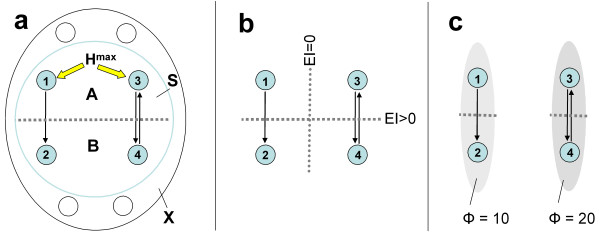
Effective information, minimum information bipartition, and complexes. a. Effective information. Shown is a single subset S of 4 elements ({1,2,3,4}, blue circle), forming part of a larger system X (black ellipse). This subset is bisected into A and B by a bipartition ({1,3}/{2,4}, indicated by the dotted grey line). Arrows indicate causally effective connections linking A to B and B to A across the bipartition (other connections may link both A and B to the rest of the system X). To measure EI(A→B), maximum entropy Hmax is injected into the outgoing connections from A (corresponding to independent noise sources). The entropy of the states of B that is due to the input from A is then measured. Note that A can affect B directly through connections linking the two subsets, as well as indirectly via X. Applying maximum entropy to B allows one to measure EI(B→A). The effective information for this bipartition is EI(A  B) = EI(A→B) + EI(B→A). b. Minimum information bipartition. For subset S = {1,2,3,4}, the horizontal bipartition {1,3}/{2,4} yields a positive value of EI. However, the bipartition {1,2}/{3,4} yields EI = 0 and is a minimum information bipartition (MIB) for this subset. The other bipartitions of subset S = {1,2,3,4} are {1,4}/{2,3}, {1}/{2,3,4}, {2}/{1,3,4}, {3}/{1,2,4}, {4}/{1,2,3}, all with EI>0. c. Analysis of complexes. By considering all subsets of system X one can identify its complexes and rank them by the respective values of Φ – the value of EI for their minimum information bipartition. Assuming that other elements in X are disconnected, it is easy to see that Φ>0 for subset {3,4} and {1,2}, but Φ = 0 for subsets {1,3}, {1,4}, {2,3}, {2,4}, {1,2,3}, {1,2,4}, {1,3,4}, {2,3,4}, and {1,2,3,4}. Subsets {3,4} and {1,2} are not part of a larger subset having higher Φ, and therefore they constitute complexes. This is indicated schematically by having them encircled by a grey oval (darker grey indicates higher Φ). Methodological note. In order to identify complexes and their Φ(S) for systems with many different connection patterns, each system X was implemented as a stationary multidimensional Gaussian process such that values for effective information could be obtained analytically (details in [8]). Briefly, in order to identify complexes and their Φ(S) for systems with many different connection patterns, we implemented numerous model systems X composed of n neural elements with connections CONij specified by a connection matrix CON(X) (no self-connections). In order to compare different architectures, CON(X) was normalized so that the absolute value of the sum of the afferent synaptic weights per element corresponded to a constant value w<1 (here w = 0.5). If the system's dynamics corresponds to a multivariate Gaussian random process, its covariance matrix COV(X) can be derived analytically. As in previous work, we consider the vector X of random variables that represents the activity of the elements of X, subject to independent Gaussian noise R of magnitude c. We have that, when the elements settle under stationary conditions, X = X * CON(X) + cR. By defining Q = (1-CON(X))-1 and averaging over the states produced by successive values of R, we obtain the covariance matrix COV(X) = <X*X> = <Qt * Rt * R * Q> = Qt * Q, where the superscript t refers to the transpose. Under Gaussian assumptions, all deviations from independence among the two complementary parts A and B of a subset S of X are expressed by the covariances among the respective elements. Given these covariances, values for the individual entropies H(A) and H(B), as well as for the joint entropy of the subset H(S) = H(AB) can be obtained as, for example, H(A) = (1/2)ln [(2π e)n|COV(A)|], where |•| denotes the determinant. The mutual information between A and B is then given by MI(A;B) = H(A) + H(B) - H(AB). Note that MI(A:B) is symmetric and positive. To obtain the effective information between A and B within model systems, independent noise sources in A are enforced by setting to zero strength the connections within A and afferent to A. Then the covariance matrix for A is equal to the identity matrix (given independent Gaussian noise), and any statistical dependence between A and B must be due to the causal effects of A on B, mediated by the efferent connections of A. Moreover, all possible outputs from A that could affect B are evaluated. Under these conditions, EI(A→B) = MI(AHmax;B). The independent Gaussian noise R applied to A is multiplied by cp, the perturbation coefficient, while the independent Gaussian noise applied to the rest of the system is given by ci, the intrinsic noise coefficient. Here cp = 1 and ci = 0.00001 in order to emphasize the role of the connectivity and minimize that of noise. To identify complexes and obtain their capacity for information integration, one considers every subset S of X composed of k elements, with k = 2,..., n. For each subset S, we consider all bipartitions and calculate EI(A  B) for each of them. We find the minimum information bipartition MIB(S), the bipartition for which the normalized effective information reaches a minimum, and the corresponding value of Φ(S). We then find the complexes of X as those subsets S with Φ>0 that are not included within a subset having higher Φ and rank them based on their Φ(S) value. The complex with the maximum value of Φ(S) is the main complex. MATLAB functions used for calculating effective information and complexes are at .